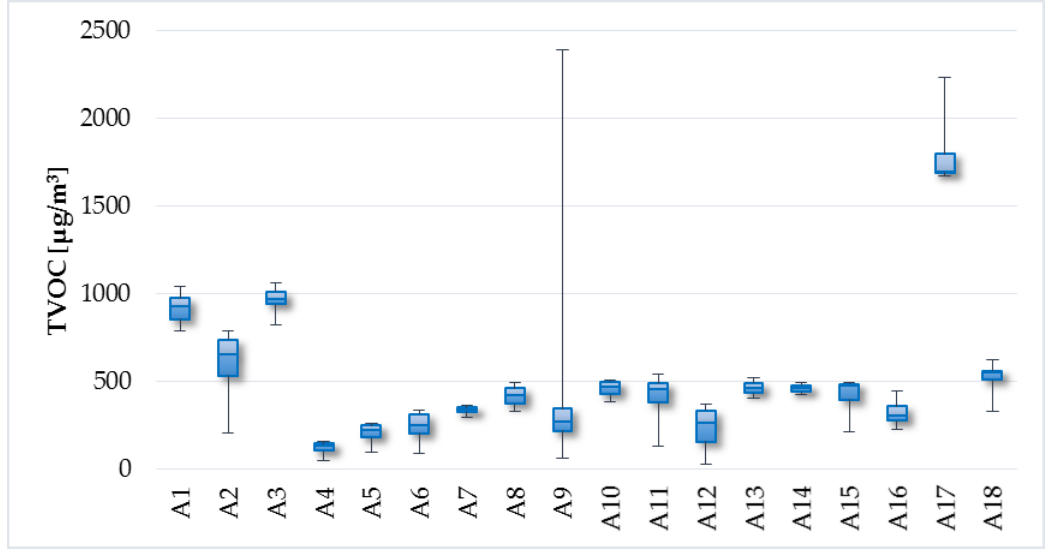
Figure 9. TVOC concentrations—the apartments.